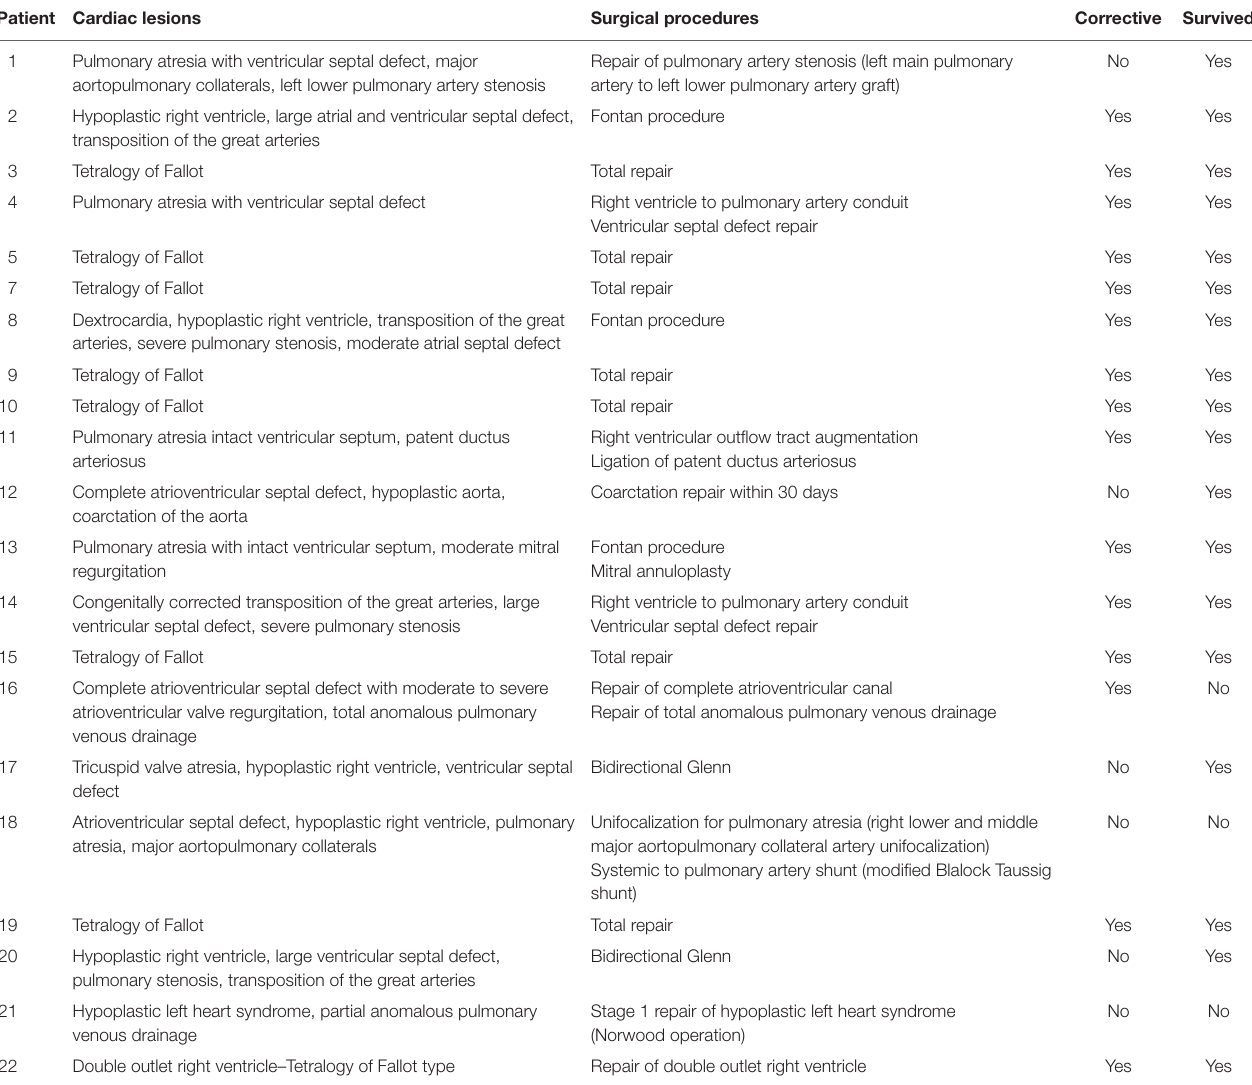
TaBle 2 | Summary of cardiac diagnosis and surgical procedures ( N = 21). Patient cardiac lesions surgical procedures corrective